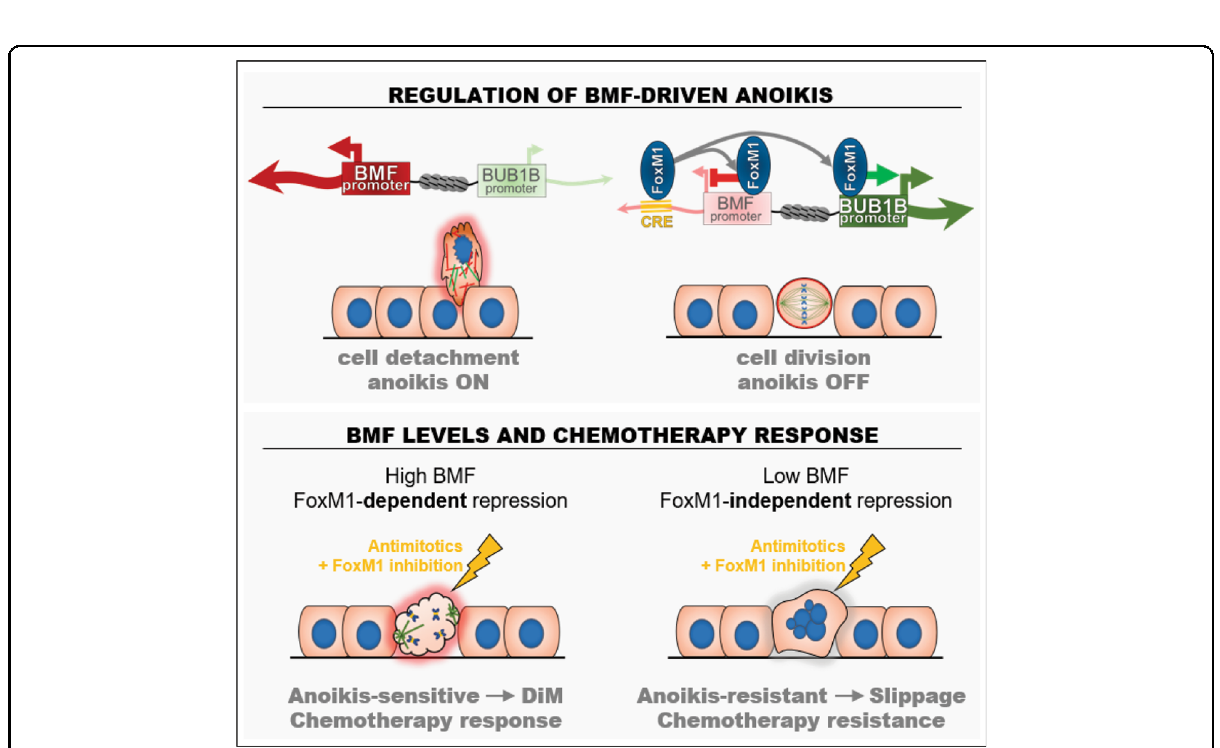
Fig. 6 Working model integrating BMF transcriptional regulation by FOXM1 in mitosis and antimitotic chemotherapy. Upper panel: FOXM1 inhibits BMF expression and anoikis induction during prolonged mitosis. A FOXM1-binding cis -regulatory element (CRE) in BMF is an enhancer of the BUB1B neighbor mitotic gene. Lower panel: FOXM1 inhibition increases DiM in response to antimitotic drugs in anoikis-sensitive cells (high BMF). FOXM1-independent BMF repression (low BMF) correlates with resistance to antimitotic